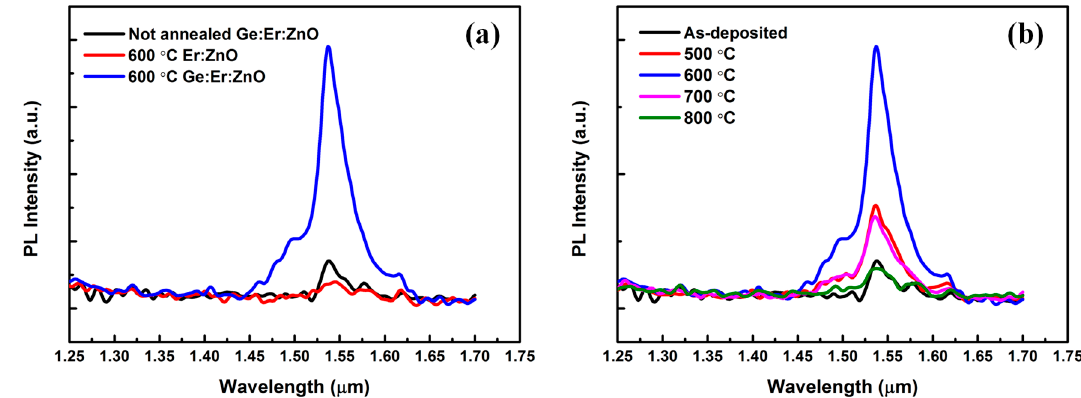
Figure 4. Infrared PL spectra of the ( a ) as-deposited Ge:Er:ZnO film, 600 °C annealed Er:ZnO and Ge:Er:ZnO films; ( b ) Ge:Er:ZnO films annealed at different temperatures.